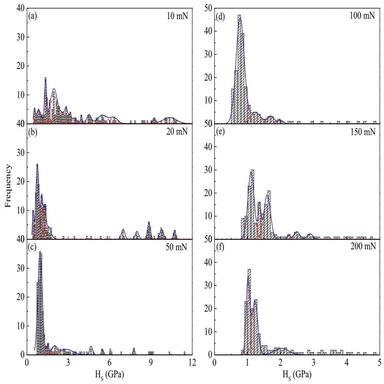
Hardness PDFs from the CL scratches with different pre-designed loading levels: (a) 10 mN (b) 20 mN, (c) 50 mN, (d) 100 mN, (e) 150 mN and (f) 200 mN.